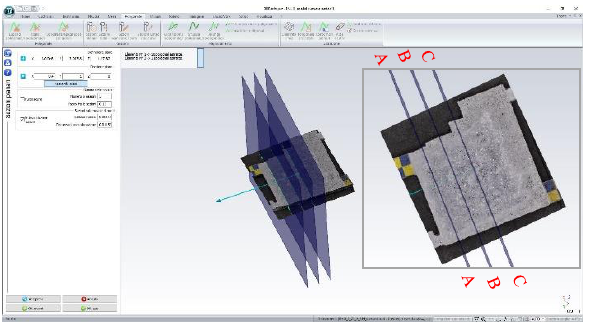
Figure 3. Section on the model